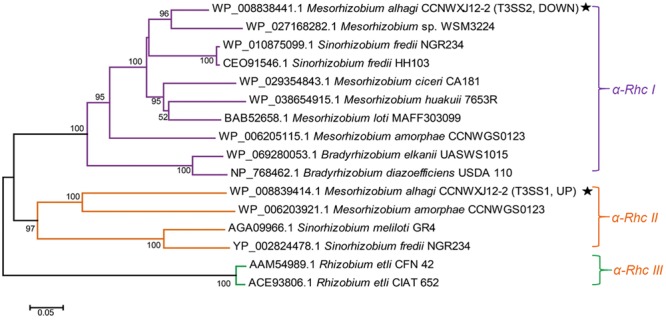
Neighbor-joining tree of RhcU sequences from two type III secretion systems (T3SSs) in the draft genome of M. alhagi CCNWXJ12-2T. The black stars indicate T3SS1 and T3SS2. UP and DOWN indicate the expression pattern of the T3SSs in high-salt conditions (3). Evolutionary distances were estimated using the p-distance method and are in units of the number of amino acid differences per site. Numbers to the left of the branches are bootstrap percentages for 1000 replications. Bootstrap values > 50% are shown, and the scale bar represents the number of substitutions per site. Evolutionary analysis was conducted using MEGA 5.1 (Tamura et al., 2011).